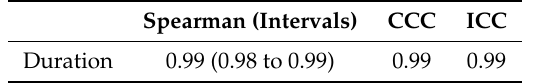
Table 3. Agreement computed with Spearman correlation (95% confidence intervals), concordance correlation coefficient (CCC) and intra-class correlation (ICC) analysis.